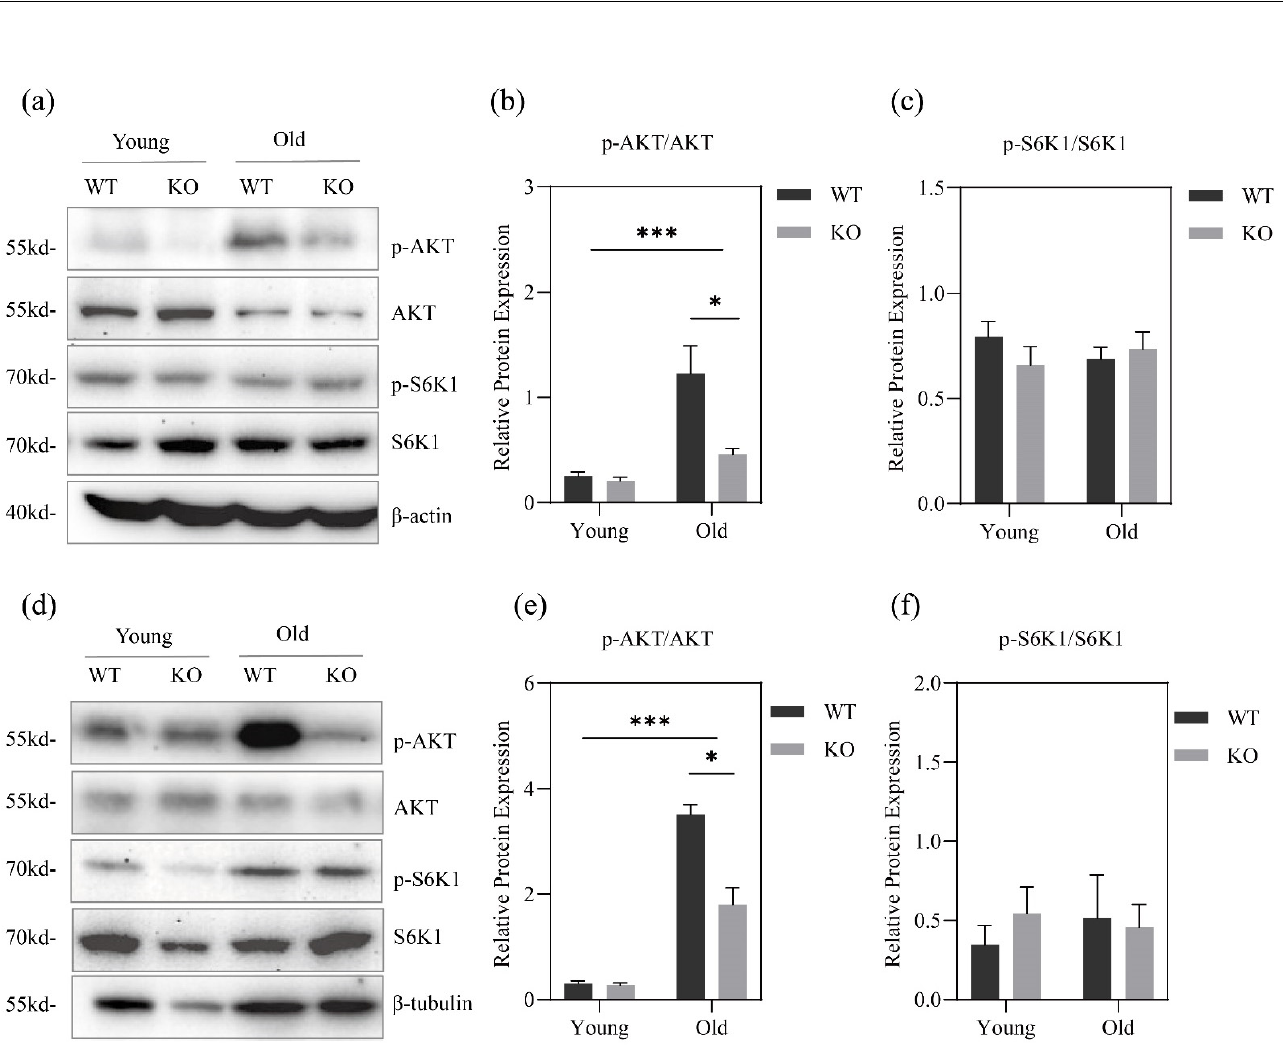
Figure 4. Effects of GPRC6A deletion on the expression of mTORC1 pathway-related proteins in 8-week-old and 55-week-old mice. ( a ) Western blots of mice liver protein expression. ( b , c ) Statistics of mice liver protein expression. ( d ) Western blots of mice skeletal muscle protein expression. ( e , f ) Statistics of mice skeletal muscle protein expression. Phosphorylated proteins were referenced to total proteins. The data were analyzed by two-way ANOVA and unpaired Student’s t -test under the same age, * p < 0.05, *** p < 0.001, n = 3.